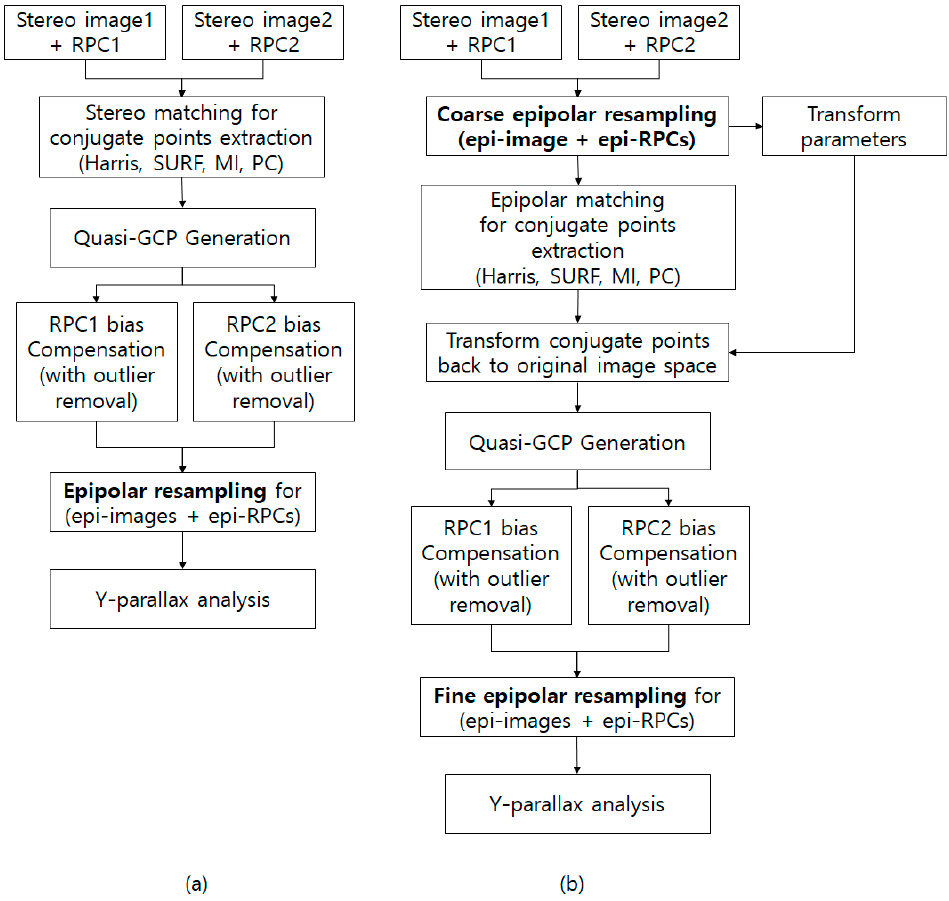
Figure1. Comparisonofresamplingmethodsforthree-dimensional(3D)mapping: ( a )singleresampling Figure 1. Comparison of resampling methods for three-dimensional (3D) mapping: ( a ) single and ( b ) double resampling and ( b ) double resampling.